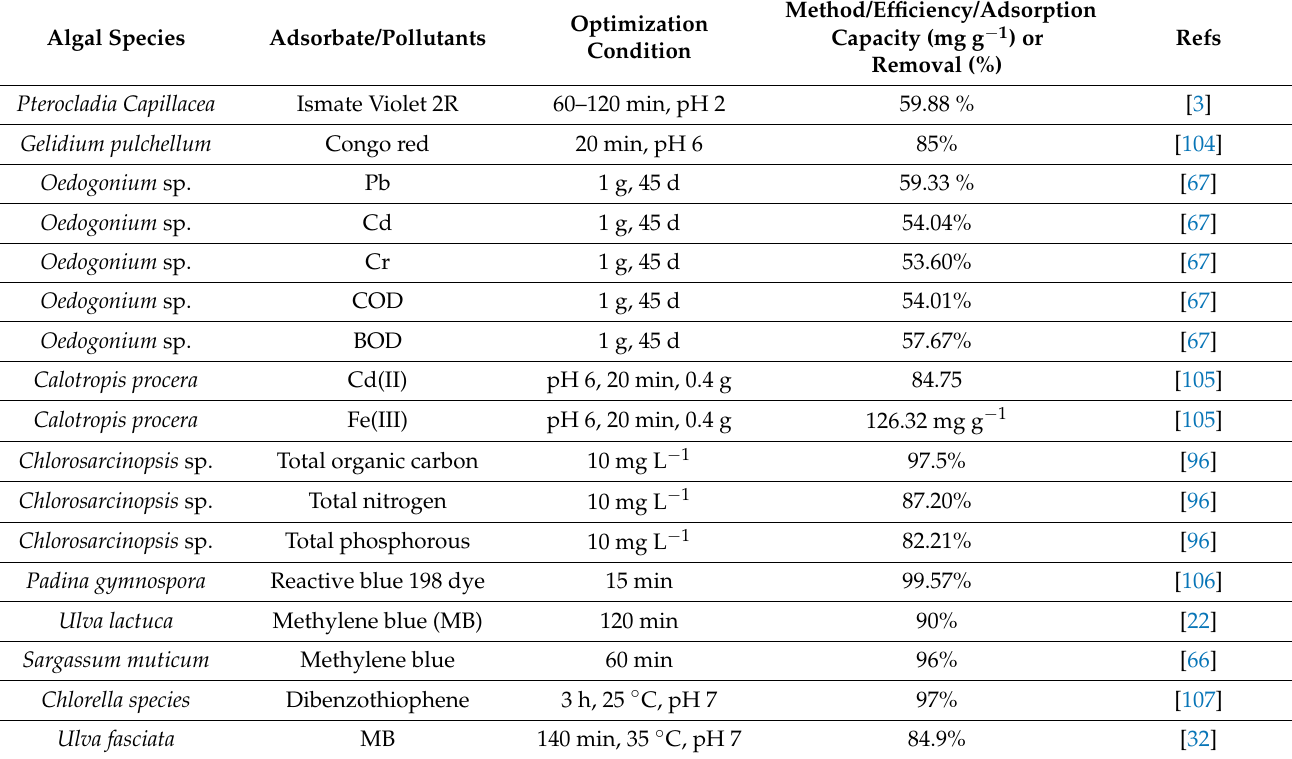
Table 3. Metal oxide-based nanomaterials for removal of organic and inorganic pollutants in